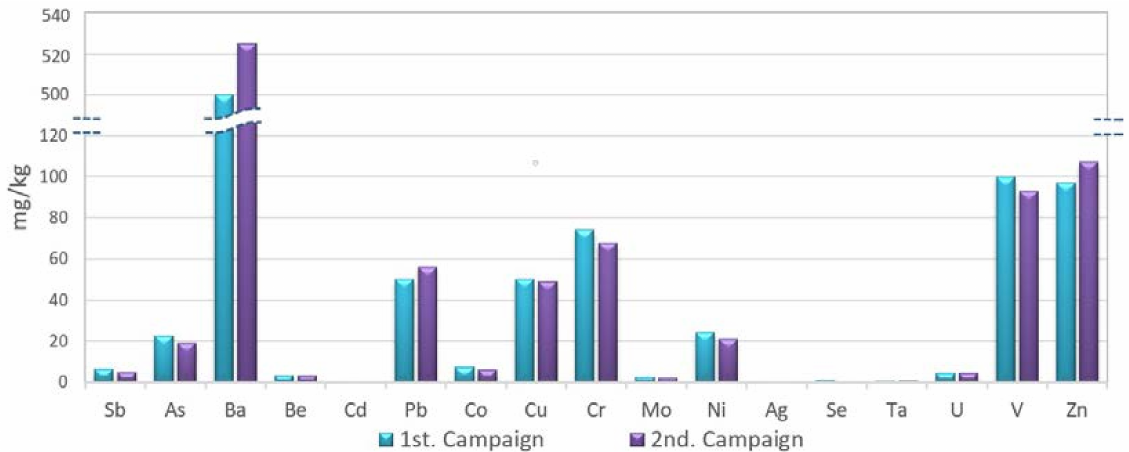
Figure 11. Average trace element concentrations in the soils (mg/kg) from two sampling campaigns.